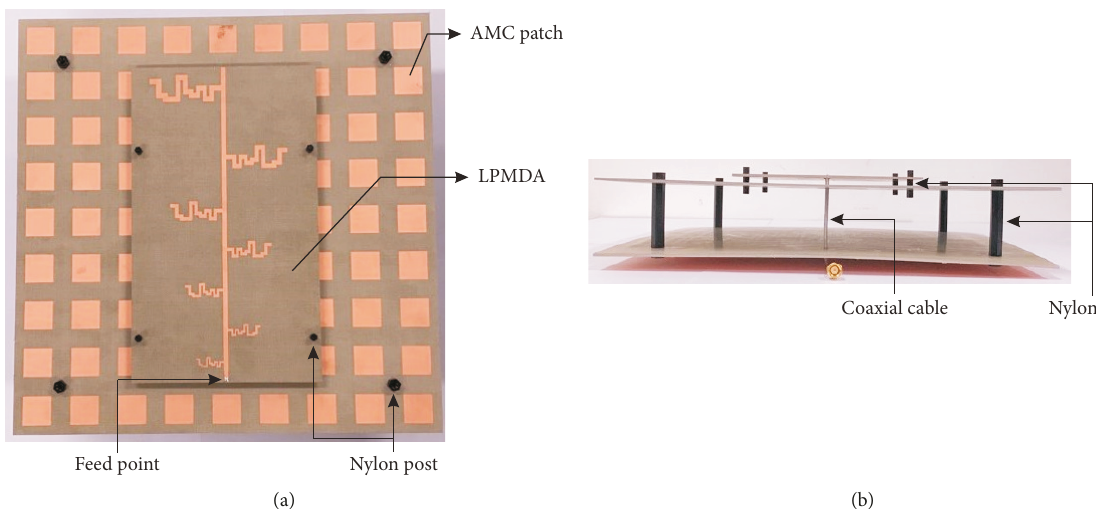
Figure 11: Photograph of the fabricated antenna with the AMC: (a) top view and (b) side view.